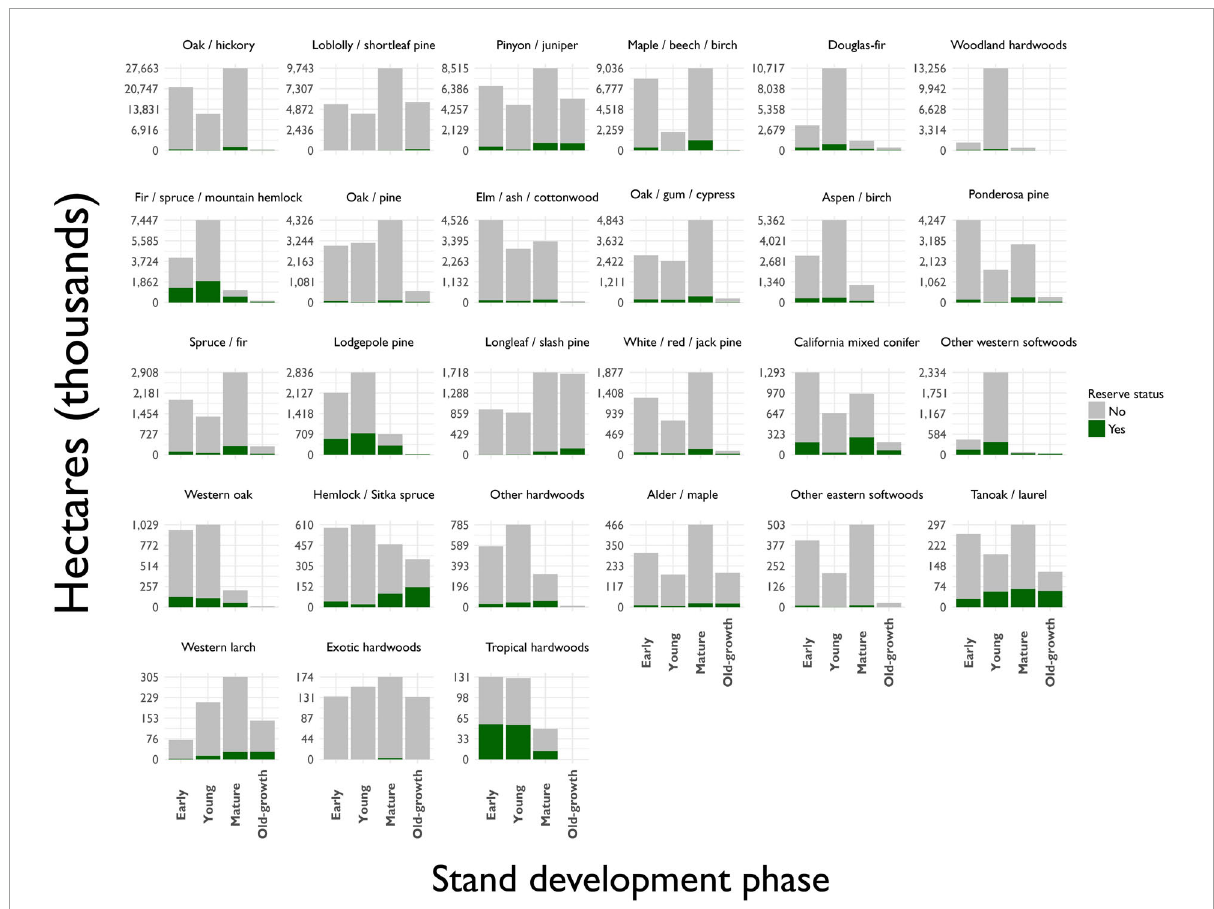
FIGURE5 Distribution of forested area by forest type-group, stand development phase and reserve status. Reserves are defined by FIA as public lands permanently prohibited from being managed for wood production through statute or agency mandate, including wilderness areas, national parks and monuments, and most state